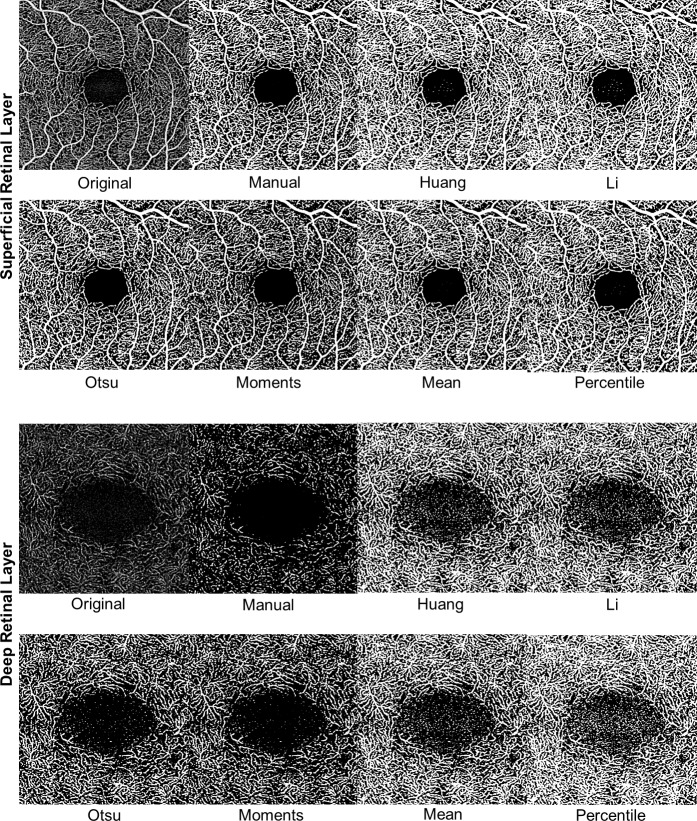
OCTA en face images of the superficial and deep retinal layers of one healthy eye.The image order from left to right is: Original image, binarized images using the manual thresholding and the Huang, Li, Otsu, Moments, Mean, Percentile algorithms.